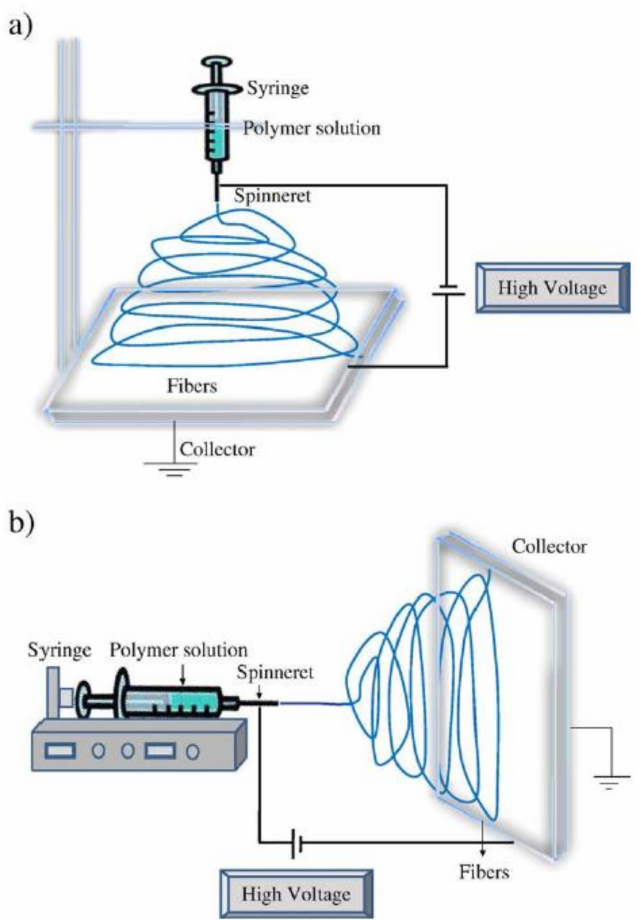
Figure 1. Schematic diagram of typical setups of an electrospinning apparatus: ( a ) vertical setup and ( b ) horizontal setup. Reprinted with permission from ref. [4]. Copyright 2010